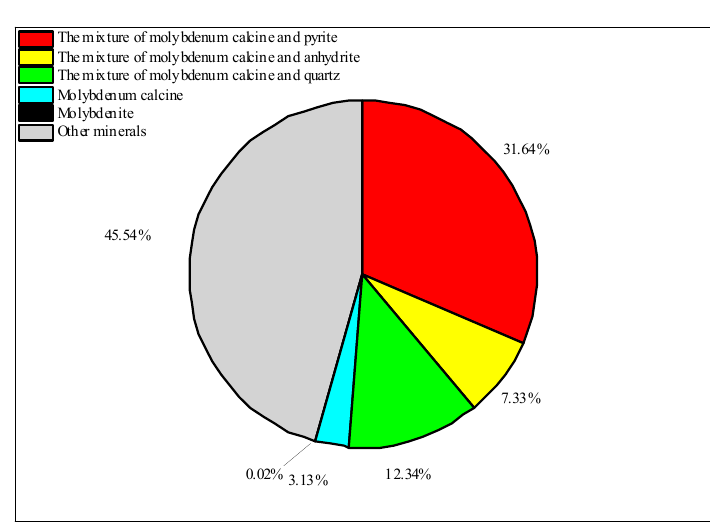
Figure 10. The existence form of molybdenum in ammonia leaching residue/%.